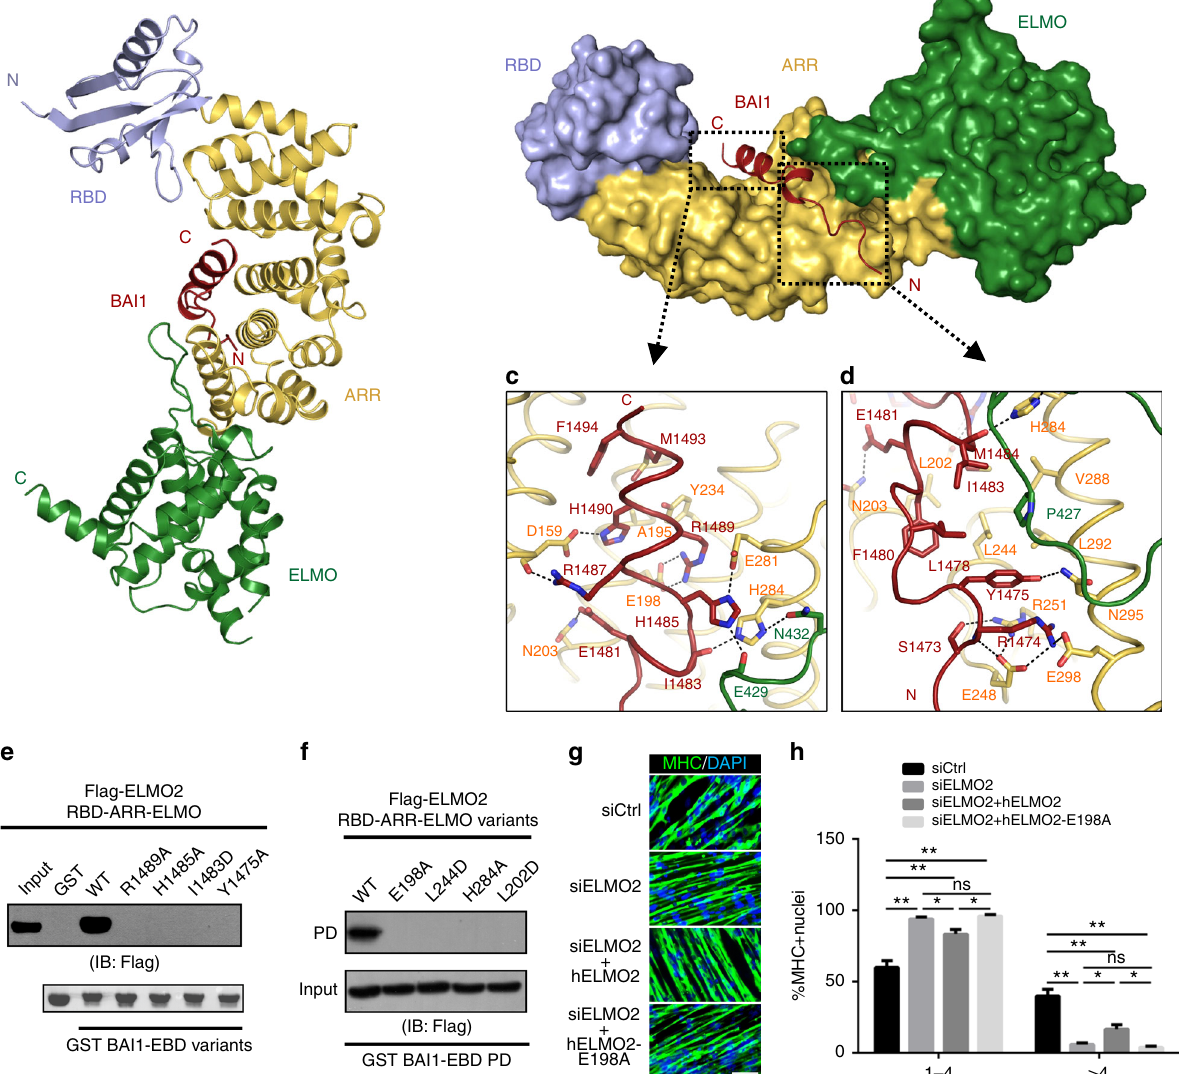
Fig. 4 The crystal structure of the BAI1/ELMO2 complex. a Ribbon diagram of overall structure of the ELMO2-RAE/BAI1-EBD complex. b The combined surface and ribbon representations of the ELMO2-RAE/BAI1-EBD complex structure. c , d Detailed interactions between ELMO2-RAE and BAI1-EBD. e , f GST-pull down-based assays showing that key residues involved in the ELMO2-RAE/BAI1-EBD interface are required for the intact interaction. PD, pull down. g Representative images of myoblast fusion showing that down-regulation of ELMO2 impairs the formation of the large myotubes with more than four nuclei in MHC positive C2C12 cells. The wild-type ELMO2, but not the BAI-binding de fi cient ELMO2-E198A mutant, signi fi cantly rescued the myoblast fusion. Scale bar, 50 µ m. h Quanti fi cation of experiments shown in g . Three independent batches of cultures were imaged for each group ( n = 1000) for quanti fi cations. All the results are presented as mean ± SEM. * p < 0.05, ** p < 0.01, *** p < 0.001, **** p <